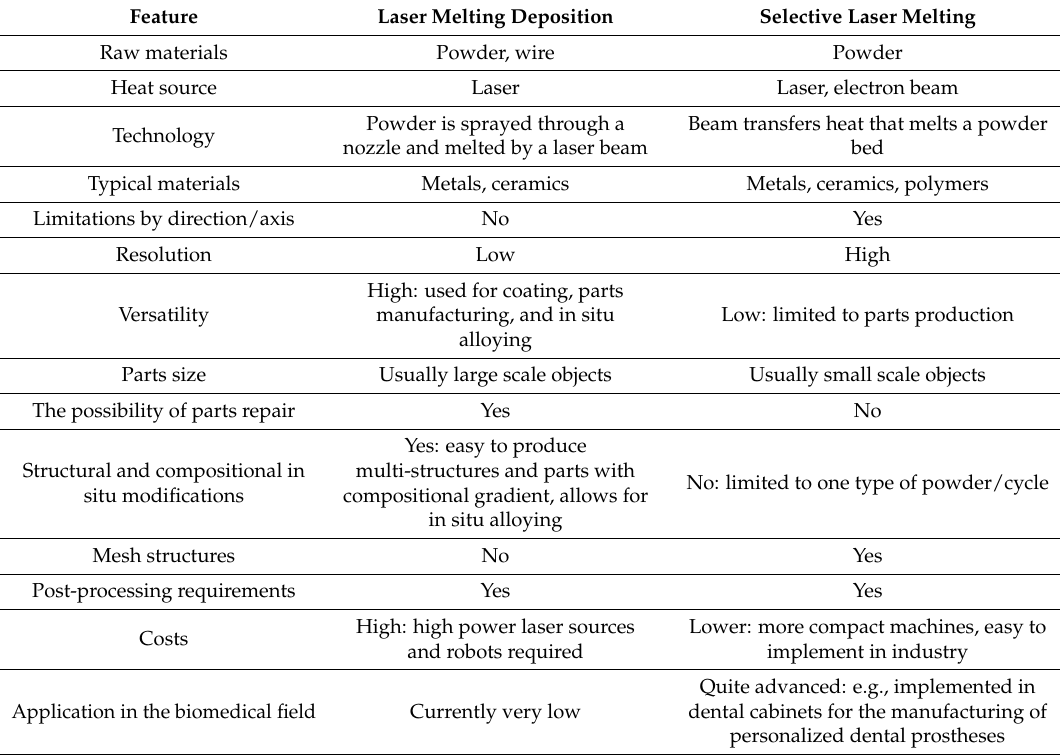
Table 1. Comparison between various features of interest for LMD and